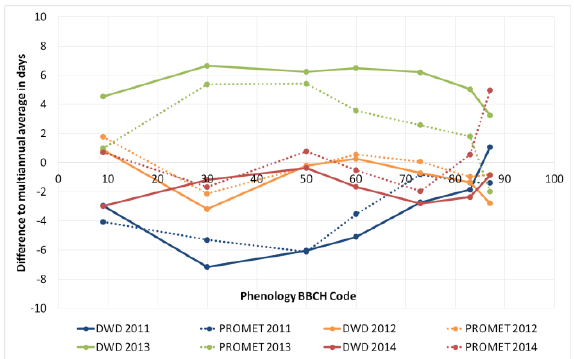
Figure 6. Validation of simulated phenological development of maize using in-situ measurements of the German Weather service DWD (averages over all 108 sites in Germany)